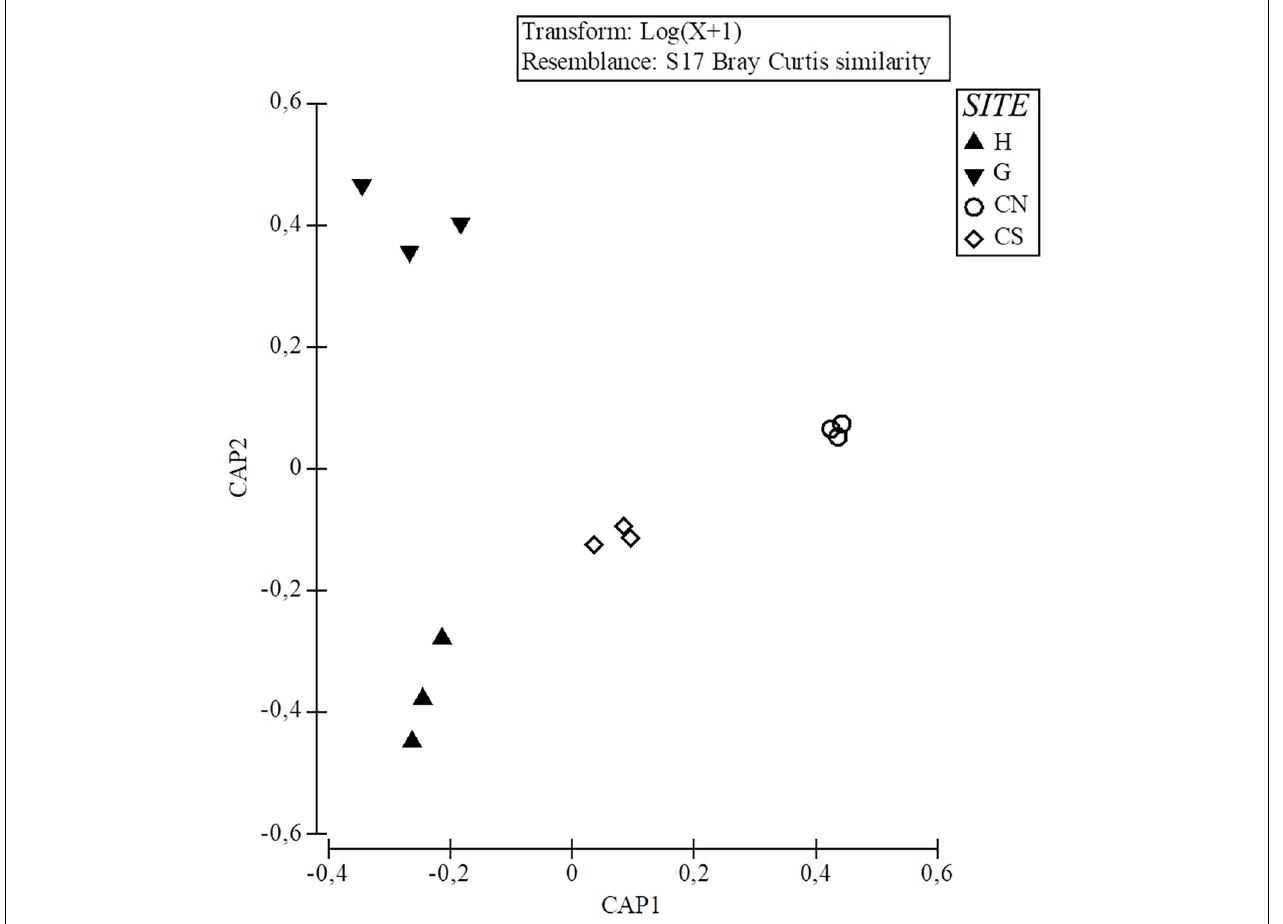
FIGURE 6 | Canonical Analysis of Principal coordinates (CAP) on benthic community dataset classified for each site (H; G; CN; CS).